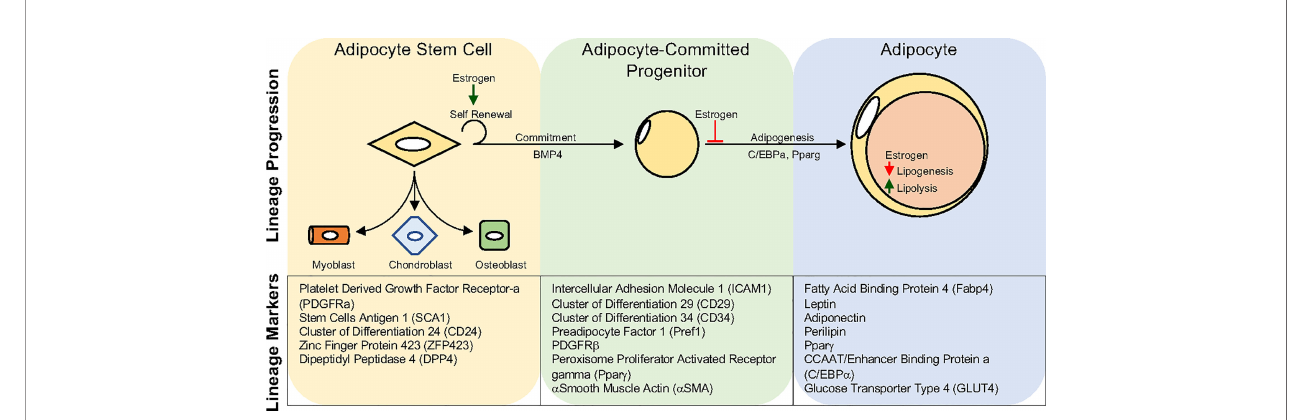
FIGURE 3 | Adipocyte Lineage progression. Adipocyte stem cells can generate committed progenitors which can undergo adipogenesis to become lipid-laden adipocytes. Developmental fate mapping, fl ow cytometry, and single-cell sequencing methodologies have identi fi ed unique and overlapping markers for each step during lineage maturation. Estrogen has been shown to regulate various aspects of the adipocyte lineage progression and mature adipocyte function. Yet, estrogens role may vary depending on depot and